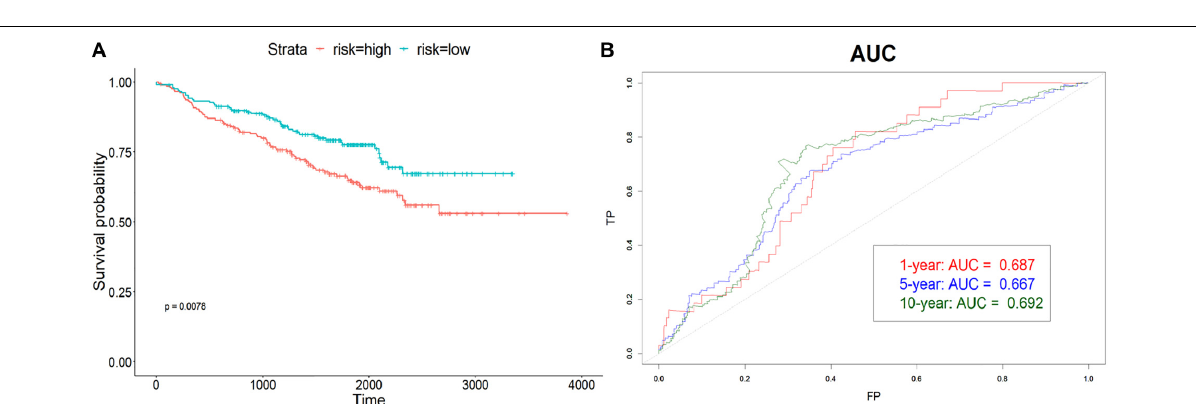
FIGURE 3 | Construction of the immune-related lncRNA signature. (A) The LASSO coefficient profiles of 19 prognosis-related lncRNAs. Each colored line showed the change of the coefficient of one lncRNA with the normalization factor. (B) Partial likelihood deviance was plotted against the logarithm of lambda in the 10-fold cross-validation. The red dots indicated the deviance and the gray vertical lines indicated standard error of the deviance. The gray vertical dotted line corresponded to the optimal lambda with the lowest partial likelihood deviance. (C) Kaplan–Meier curve of high-risk and low-risk groups. (D) The AUC of 1-, 5-, and 10-year OS. The x -axis represented the false-positive (FP) rate, and the y -axis represented the true-positive (TP) rate. The signature predicted the 10-year survival best.